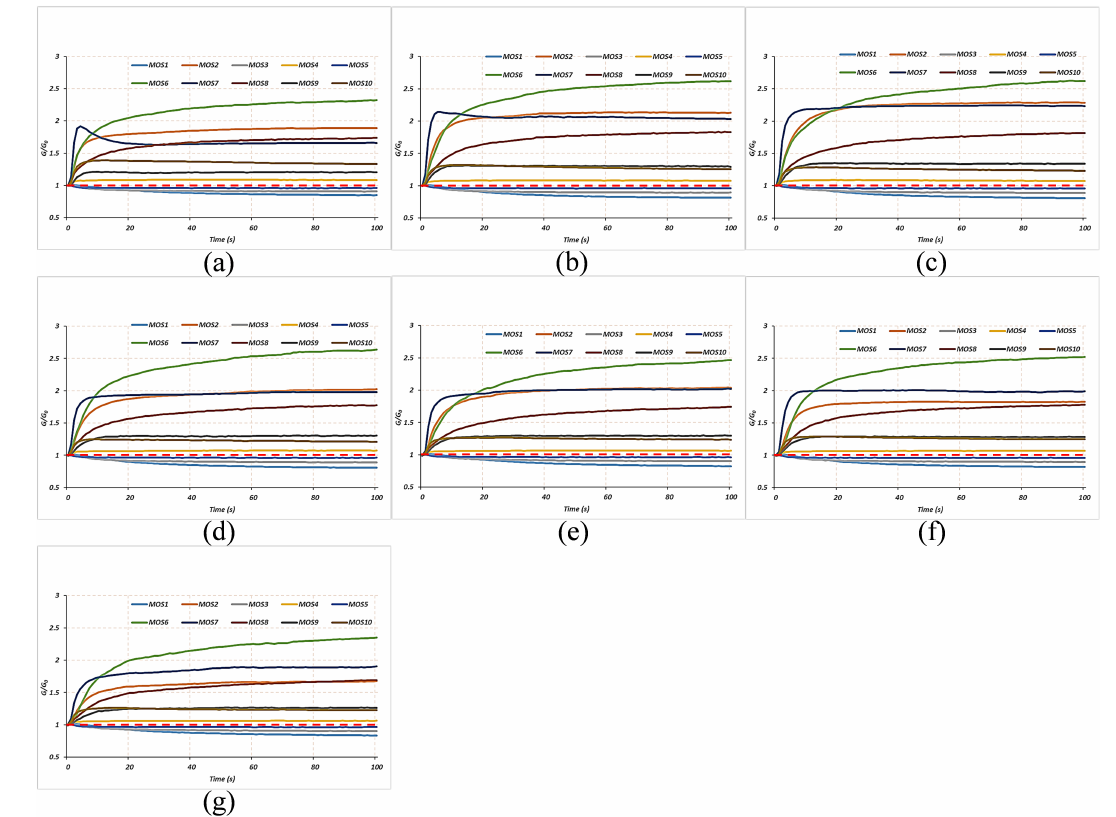
Figure 2. Example response curves of the 10 E-nose sensors (the baseline is marked with the red dotted line): ( a ) proportion of 0%; ( b ) proportion of 10%; ( c ) proportion of 20%; ( d ) proportion of 30%; ( e ) proportion of 40%; ( f ) proportion of 50%; ( g ) proportion of